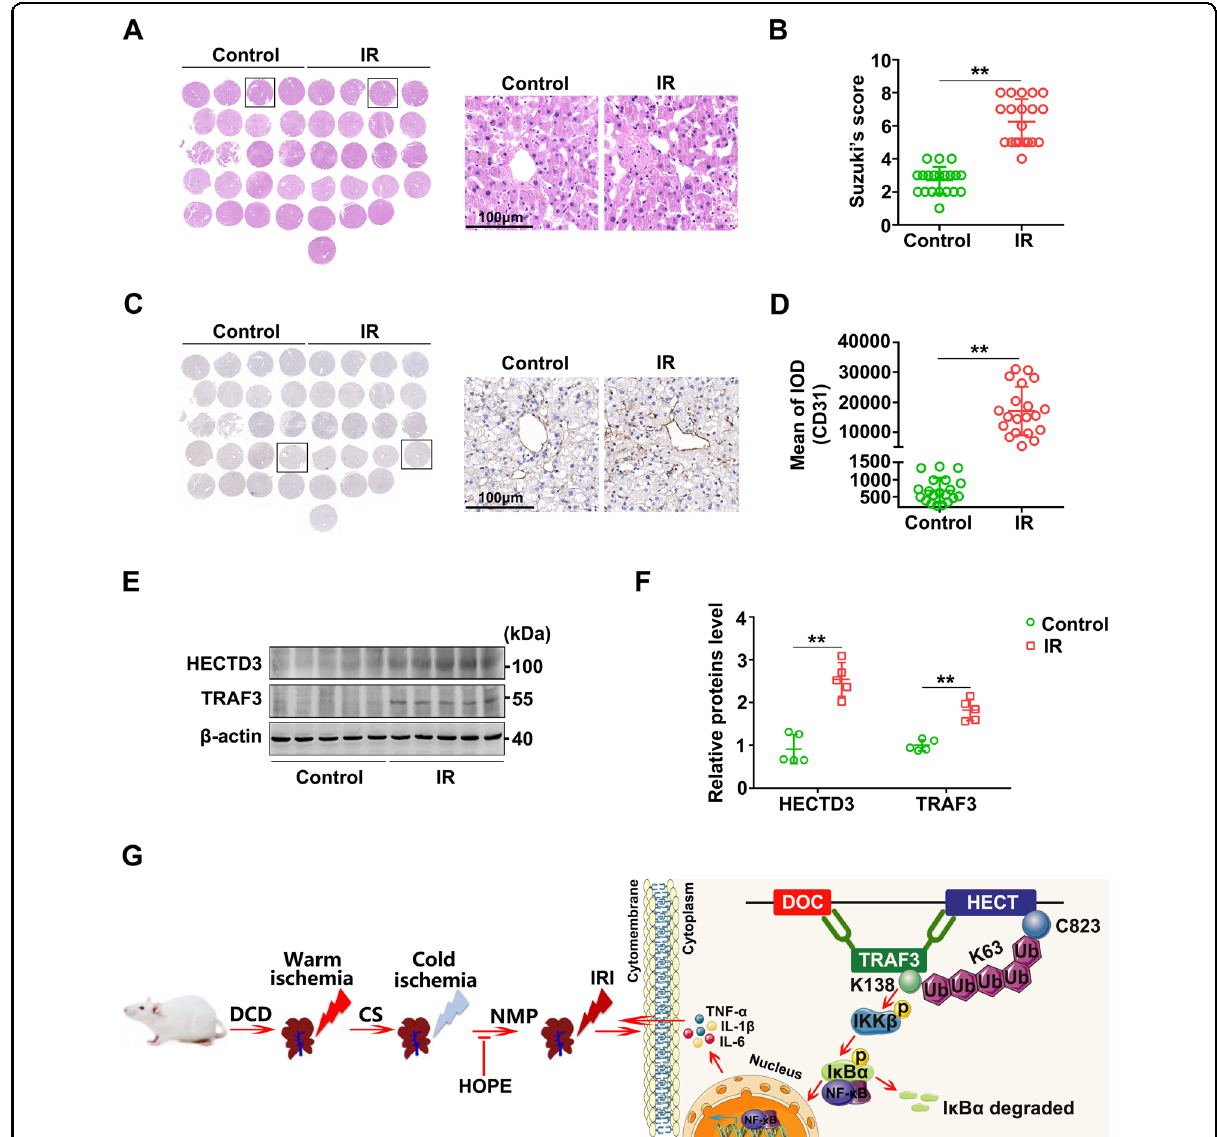
Fig. 8 Human liver IRI promotes the expression of HECTD3 and TRAF3. A, B Histological damage in human liver. Overview of a TMA section stained with H&E. Histological change was observed using a microscope ( A ). The right panel is a representative enlarged image. Scale bar = 100 μ m. Histological scores were analyzed depending on Suzuki ’ s criteria ( B ). Data are mean ± SD, ** P < 0.01 by Student ’ s two-tailed unpaired t -test. n = 20 per group. C , D Activation of LSECs in human liver. Overview of a TMA section stained with IHC. The right panel is a representative enlarged image. Scale bar = 100 μ m. IHC stained fl uorescence of CD31 was quanti fi ed using Image-pro plus 6.0. Data are mean ± SD, ** P < 0.01 by Student ’ s two- tailed unpaired t -test. n = 20 per group. E , F HECTD3 and TRAF3 proteins expression in human liver were evaluated using western blot ( E ) and quanti fi ed using a Gel-Pro Analyzer ( F ). Data are mean ± SD, n.s., not signi fi cant; ** P < 0.01 by two-way ANOVA followed by Tukey ’ s test. n = 5 per group. G Mechanism scheme. Warm ischemia, cold ischemia, and subsequent reperfusion phases in a DCD rat model cause the DOC and HECT domains of HECTD3 directly binding to TRAF3. Followed by the C823 of the HECT domains promotes the K63-linked polyubiquitination of TRAF3 at Lys138 to trigger the activation of NF- κ B signaling pathway, leading to the release of in fl ammatory factors to result in liver IRI. However, HOPE effectively improved the entire pathological